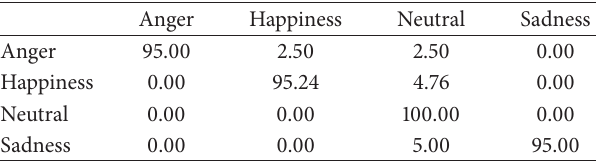
Table 7: Classification performance of the ASR system for emotion recognition on the speech corpus (training = testing